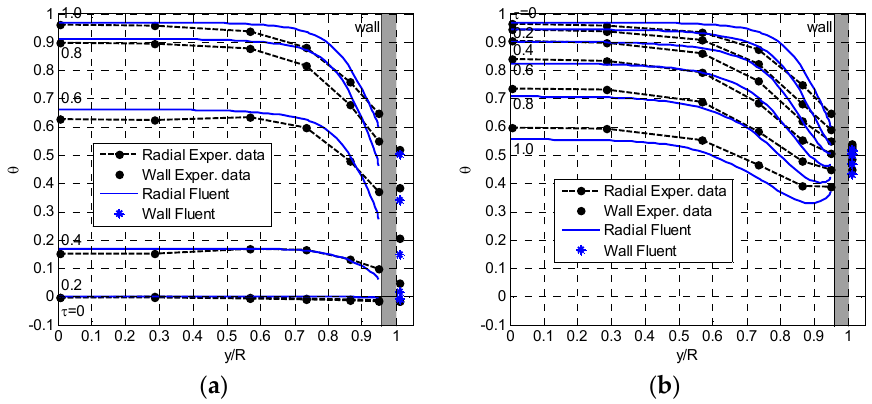
Figure 4. ( a ) Radial temperature distribution with mass flow rate of 0.15 kg/s during charging phase; ( b ) Radial temperature distribution with mass flow rate of 0.15 kg/s during discharging phase.